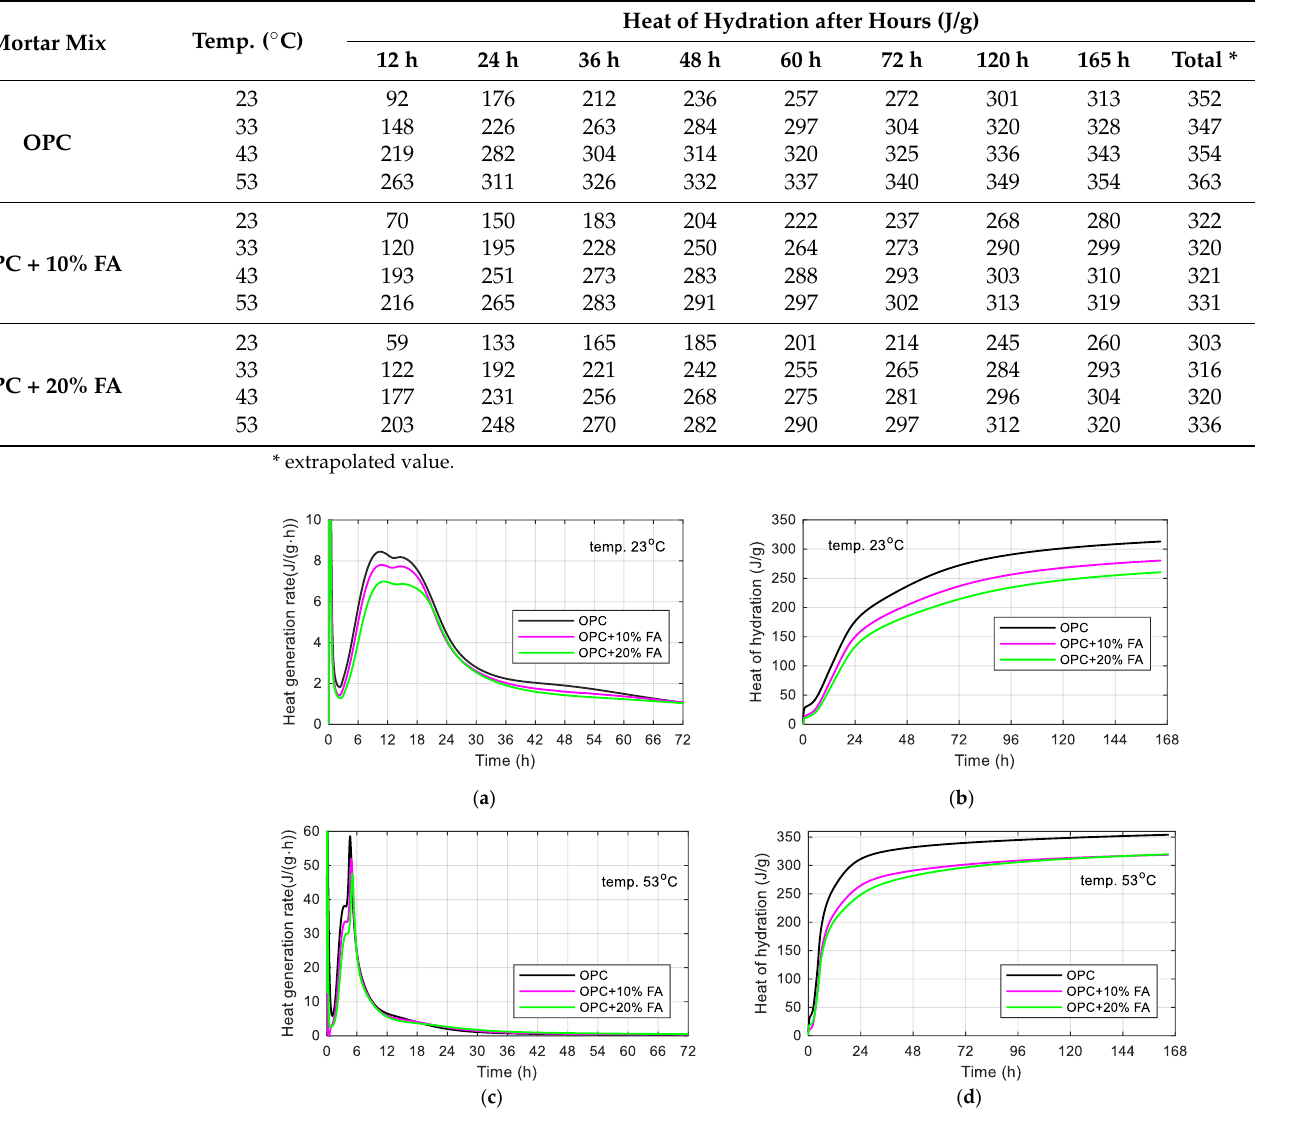
Figure 3. Effect of FA addition on the heat generation rate and heat of hydration of mortars cured at 23 °C ( a ), ( c ); and 53 °C ( b ), ( d ). Table 3. Heat of hydration.